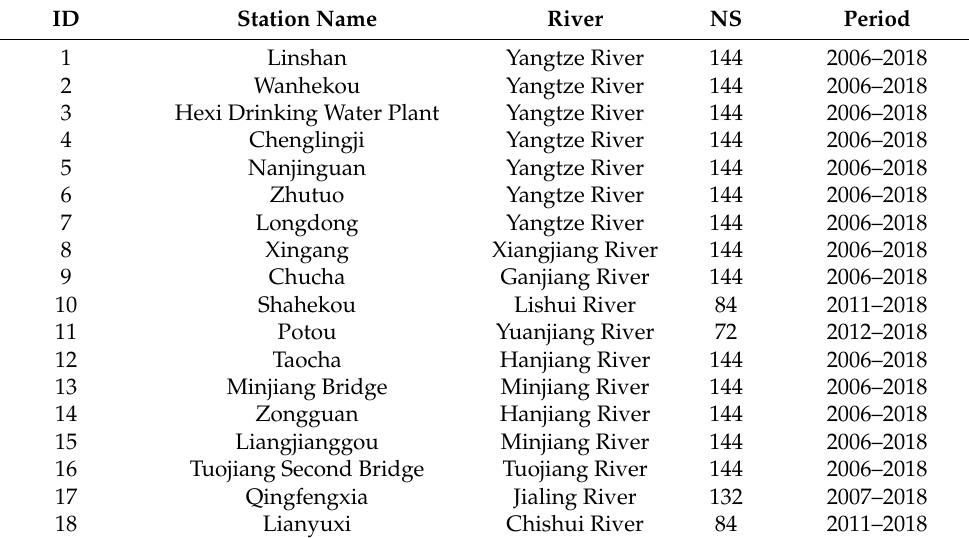
Table 1. Basic information of water quality sites in Yangtze River Basin.